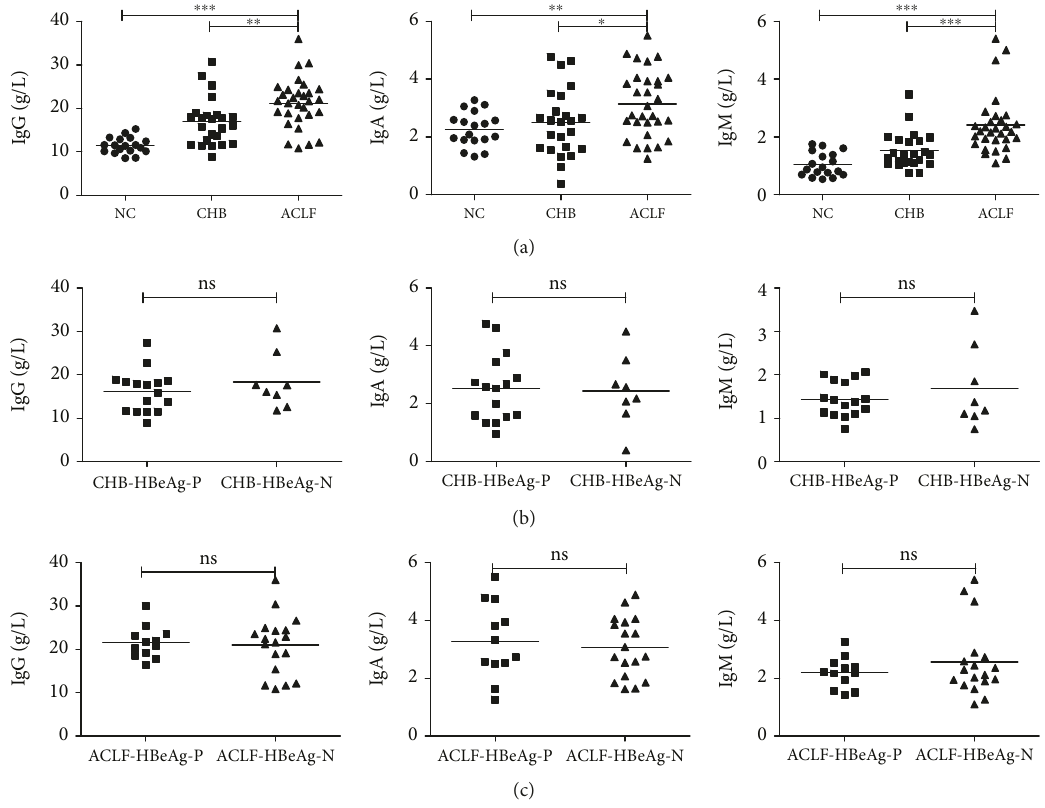
Figure 1: IgG, IgA, and IgM levels were signi fi cantly higher in HBV-ACLF patients independently of HBeAg presence. Pooled data indicated the levels of IgG, IgA, and IgM in each group, where the lines indicated the mean or median. (a) Serum IgG, IgA, and IgM levels were signi fi cantly higher in HBV-ACLF patients than in the CHB group and the NC group. No signi fi cant di ff erences existed between patients with HBeAg positive and those with HBeAg negative, neither in the CHB group (b) nor in the HBV-ACLF group (c). ACLF: acute-on-chronic liver failure; CHB: chronic hepatitis B; NC: normal control; HBeAg-P: HBeAg-positive; HBeAg-N: HBeAg-negative; ∗ P < 0 05 ; ∗∗ P < 0 01 ; ∗∗∗ P < 0 001 ; ns: not signi fi